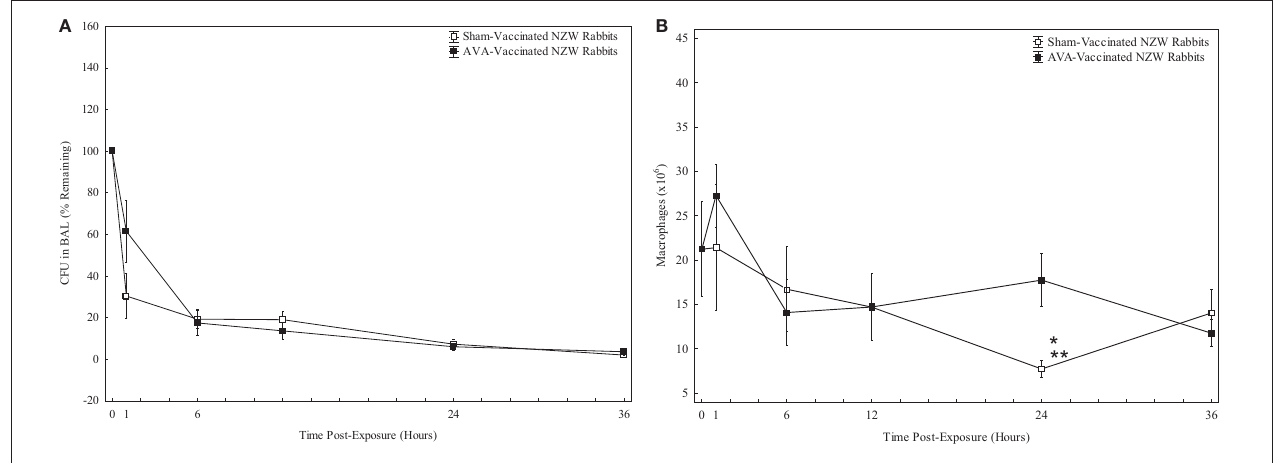
FIGURE 1 | Total bacteria (A) and macrophages (B) detected in BAL fluid. Data were collected from sham-vaccinated ( (cid:2) ) and AVA-vaccinated ( (cid:3) ) rabbits immediately following exposure (1h) and at 6, 12, 24, and 36h post-exposure. For (A) , data were collected and pooled for the 1, 6, and 12h time points from two separate experiments, and three separate experiments were used for the 24 and 36h time points [ n = 8 − 16 sham- or AVA-vaccinated rabbits per time point].